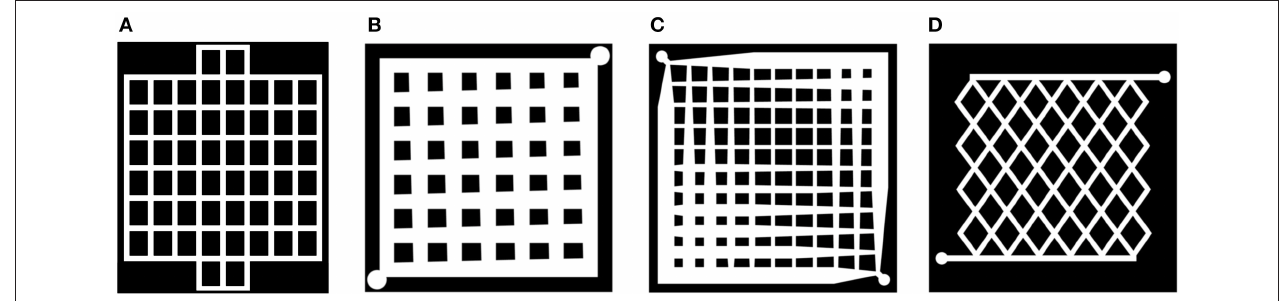
FIGURE 5 | Sketches of mesh-type design modifications: with additional areas helping the gas coalesce with water droplets, from (Kahraman and Orhan, 2017) (A) , with gradually increasing/decreasing, from (Guo et al., 2011) (B) and optimized, from (Guo et al., 2013) (C) channel widths, and intersectant geometry, from (Wang et al., 2008) (D)